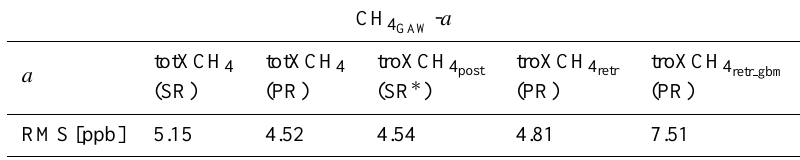
Table 9. Difference between the mean CH 4 VMR in 2001–2003 and in 2008–2010 with its associated 1 σ uncertainty. totXCH 4 totXCH 4 troXCH 4 Dataset CH 4 GAW (SR) (PR) (SR*) (PR) (PR) 19.65 26.46 25.61 26.97 22.79 26.79 Difference [ppb] ± 5.00 ± 9.19 ± 4.74 ± 7.71 ± 5.12 ±